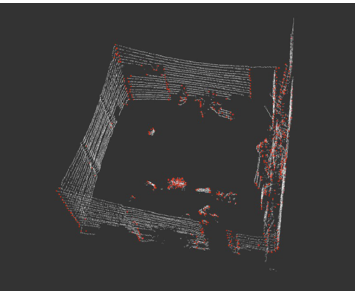
Figure 2. Detecting Edge points in semi-sparse point